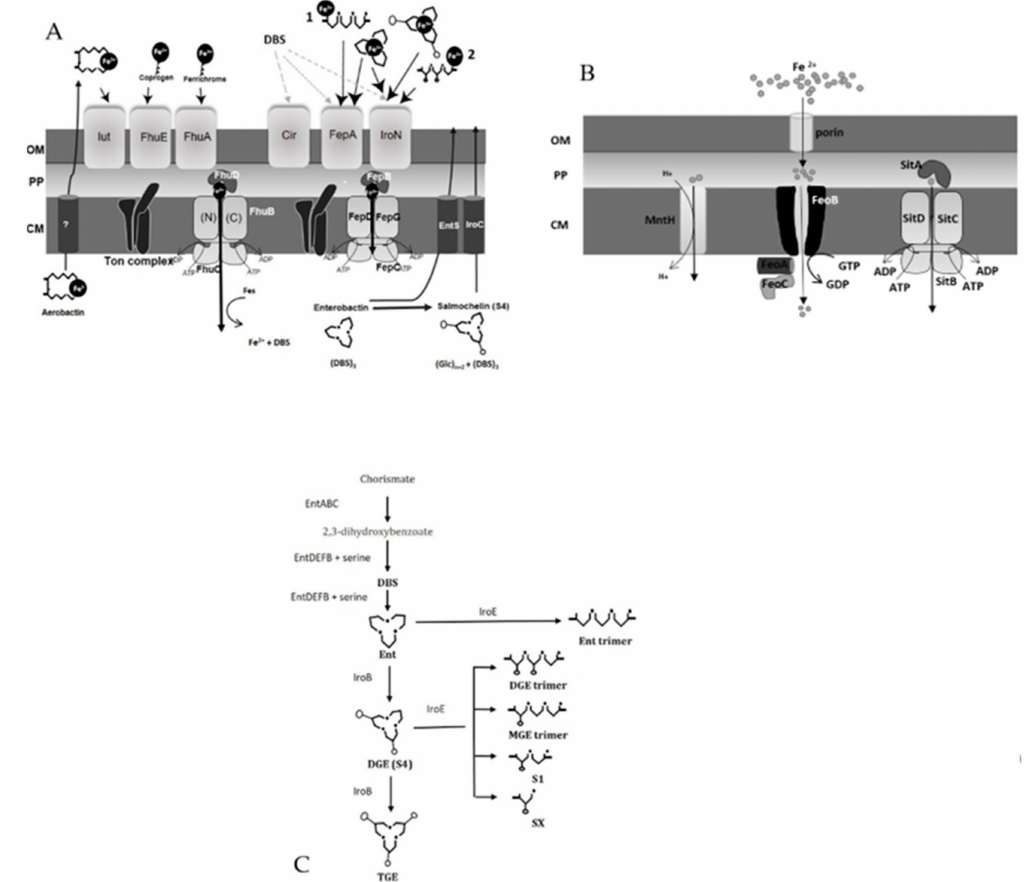
Figure 1. Schematic representation of iron-uptake systems in non-typhoidal Salmonella strains. ( A ) Fe 3 +